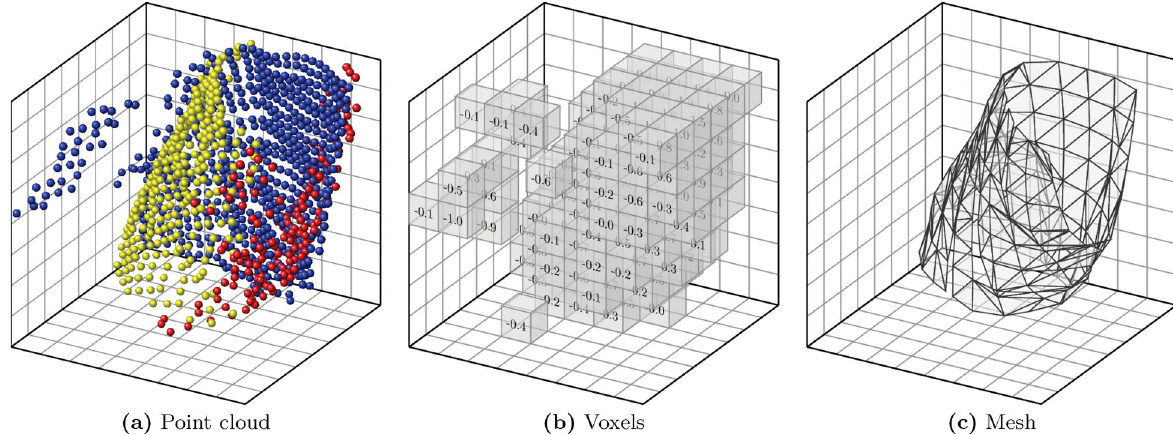
Fig. 6 Reconstruction of an 8 × 8 × 8 voxel block using real-world data. (a) Input point cloud data; colors mark different RGB-D cameras; (b) MLS voxel values (only negative voxel values are visualized); (c) meshing result after marching cubes triangulation. Note that the outlier points on the left side of the block are successfully excluded from the final result.